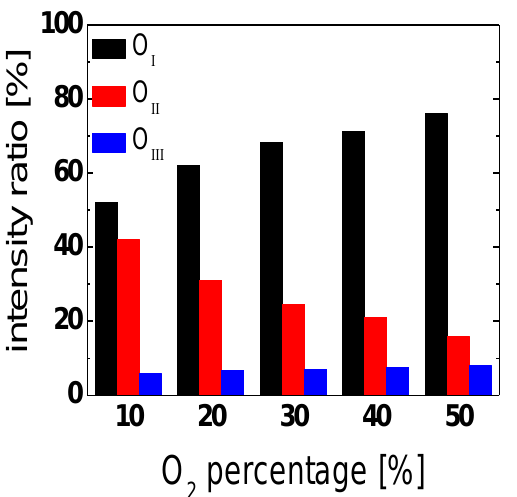
Figure 7. O 1s core-level XPS results of the IGTO thin films prepared at the oxygen contents of ( a ) 10%, ( b ) 20%, ( c ) 30%, ( d ) 40%, and ( e ) 50%.